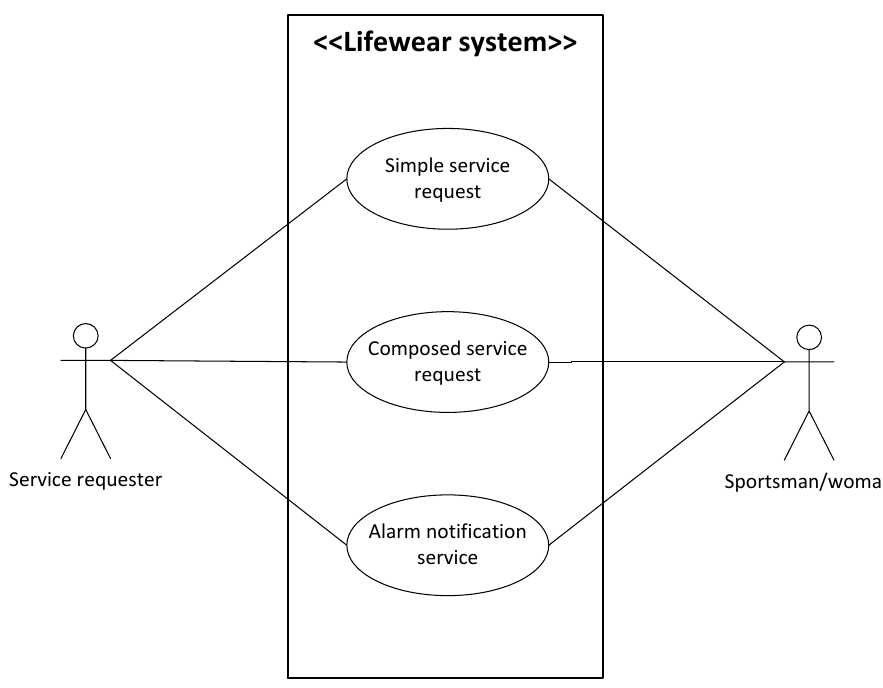
Figure 6. Use cases of the